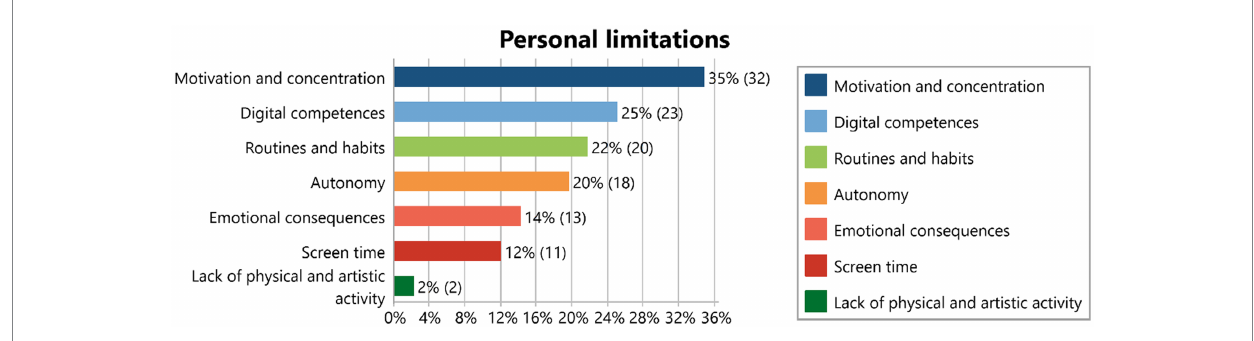
FIGURE 5 Frequency of documents referring to the subcategory Personal limitations within the category Children’s